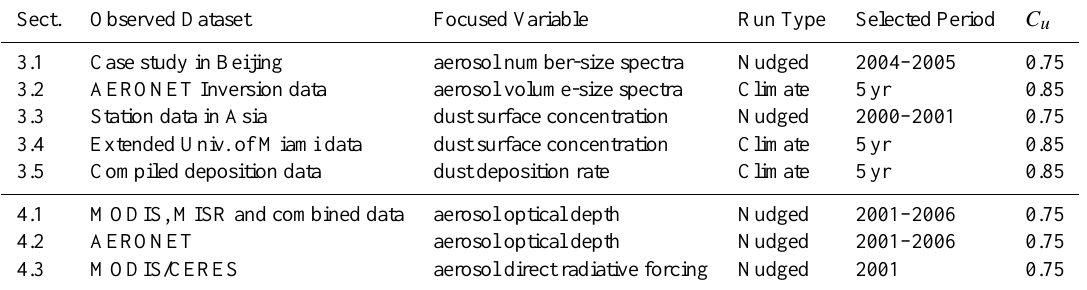
Table 2. Run types, selected time period and wind tuning parameter ( C u ) for simulations comparing with different observed datasets in Sects. 3 and 4.